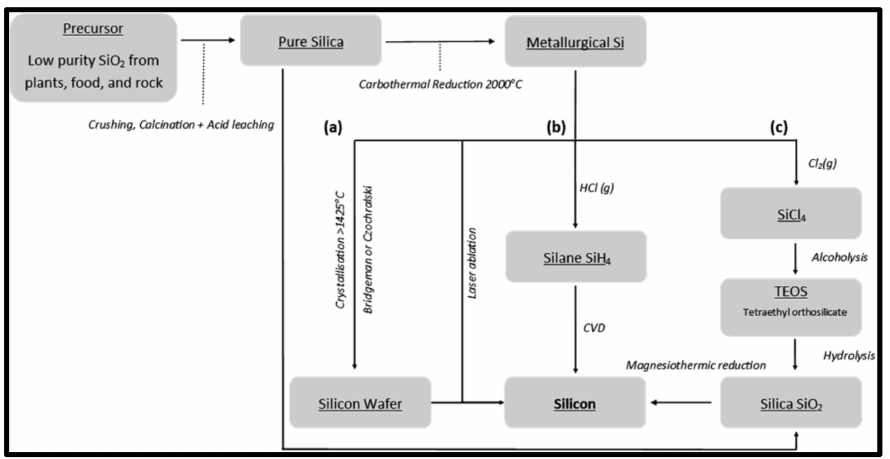
Figure 6. Flow chart of existing bulk silicon synthesis routes, including magnesium reduction